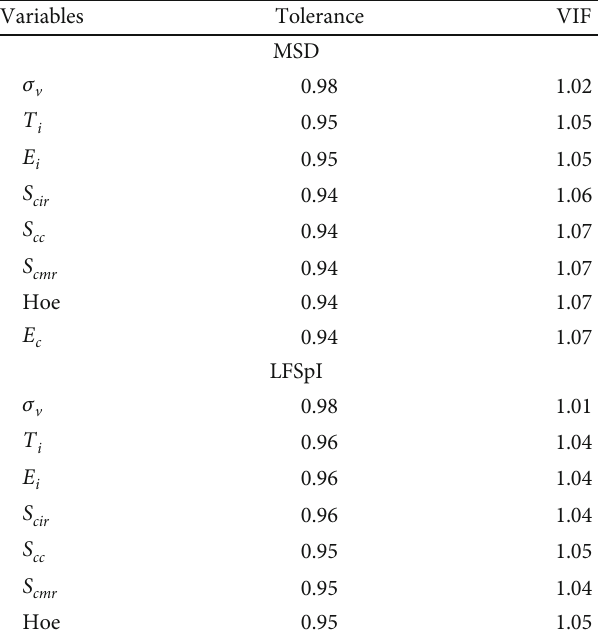
Table 6: Values of the multicollinearity diagnostic indicators for the independent variables.